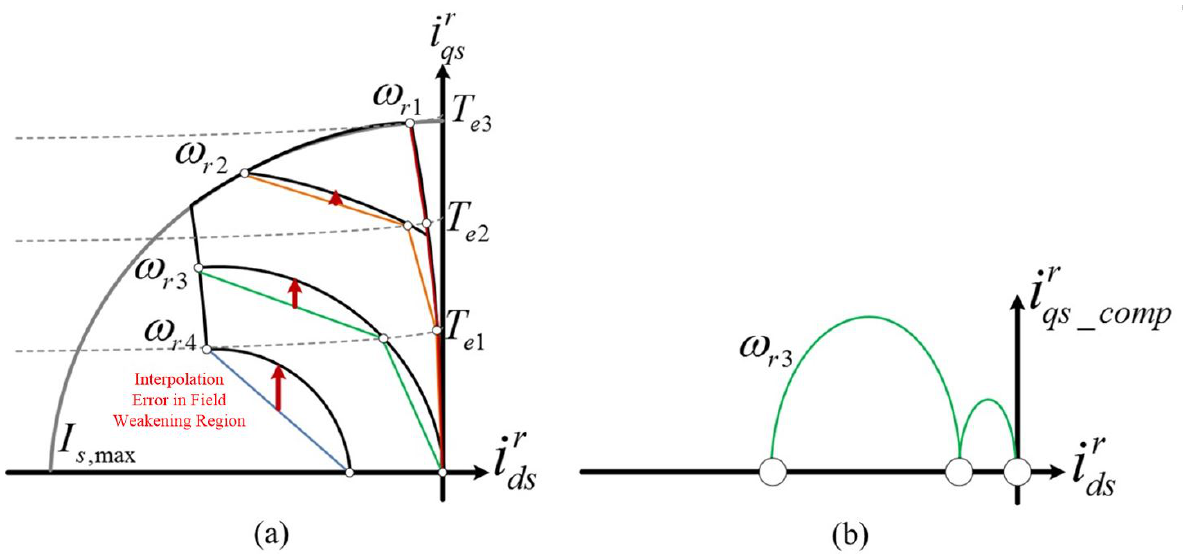
Figure 2. Interpolation error in PMSM operating region ( a ) Interpolation error in field weakening region ( b ) Compensating current for interpolation error